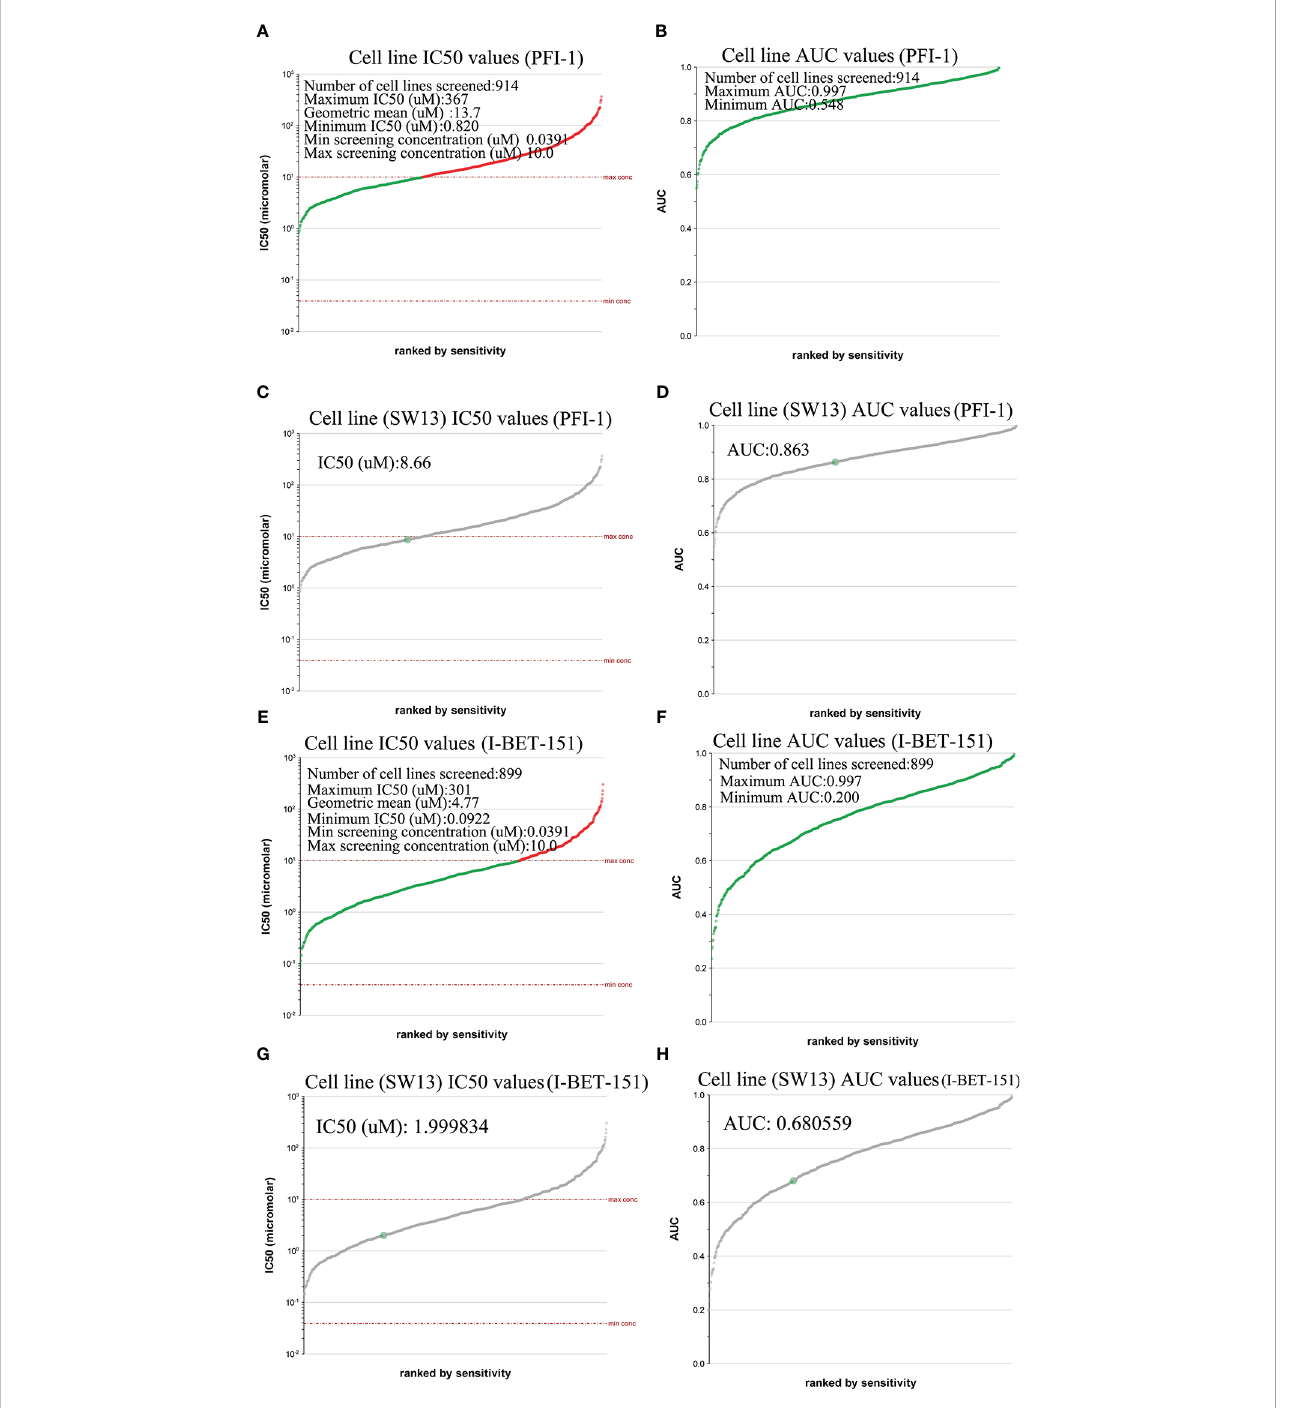
FIGURE 6 IC50 evaluation of PFI-1 and I-BET-151 in different tissue types of cancer (Genomics of Drug Sensitivity in Cancer). (A) Cell line IC50 values of PFI-1; (B) Cell line AUC values of PFI-1; (C) SW13 cell line IC50 values of PFI-1; (D) SW13cell line AUC values of PFI-1. (E) Cell line IC50 values of I-BET-151; (F) Cell line AUC values of I-BET-151; (G) SW13 Cell line IC50 values of I-BET-151; (H) SW13cell line AUC values of